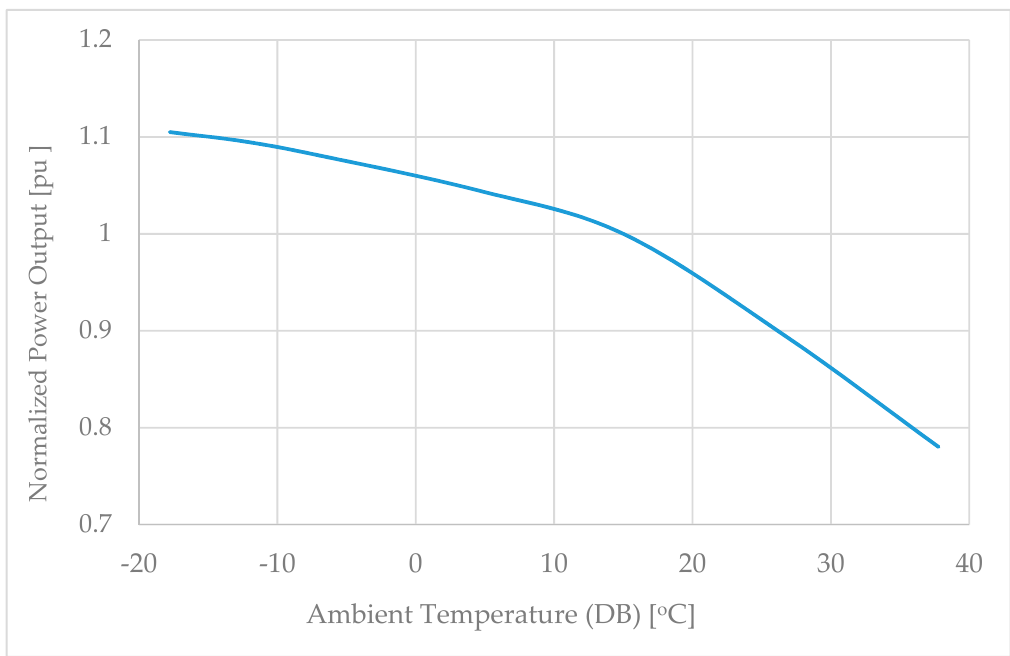
Figure 1. The Power-Temperature characteristic of an open cycle gas turbine used in this study.